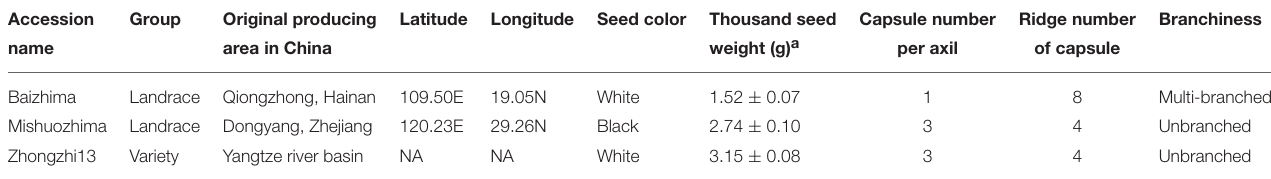
TABLE 1 | List of the landraces sequenced in this study.